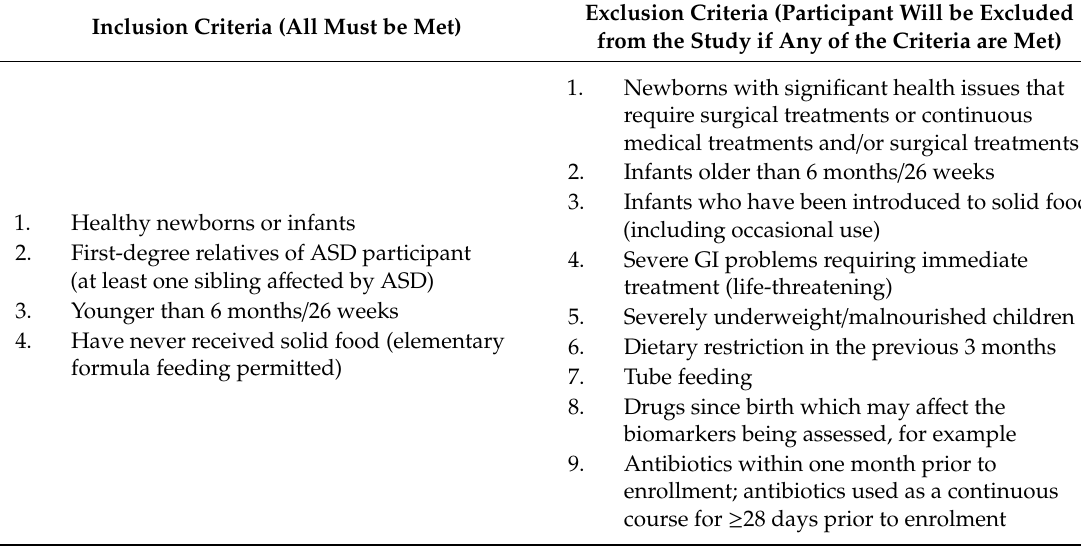
Table 1. Inclusion and exclusion criteria for the observational